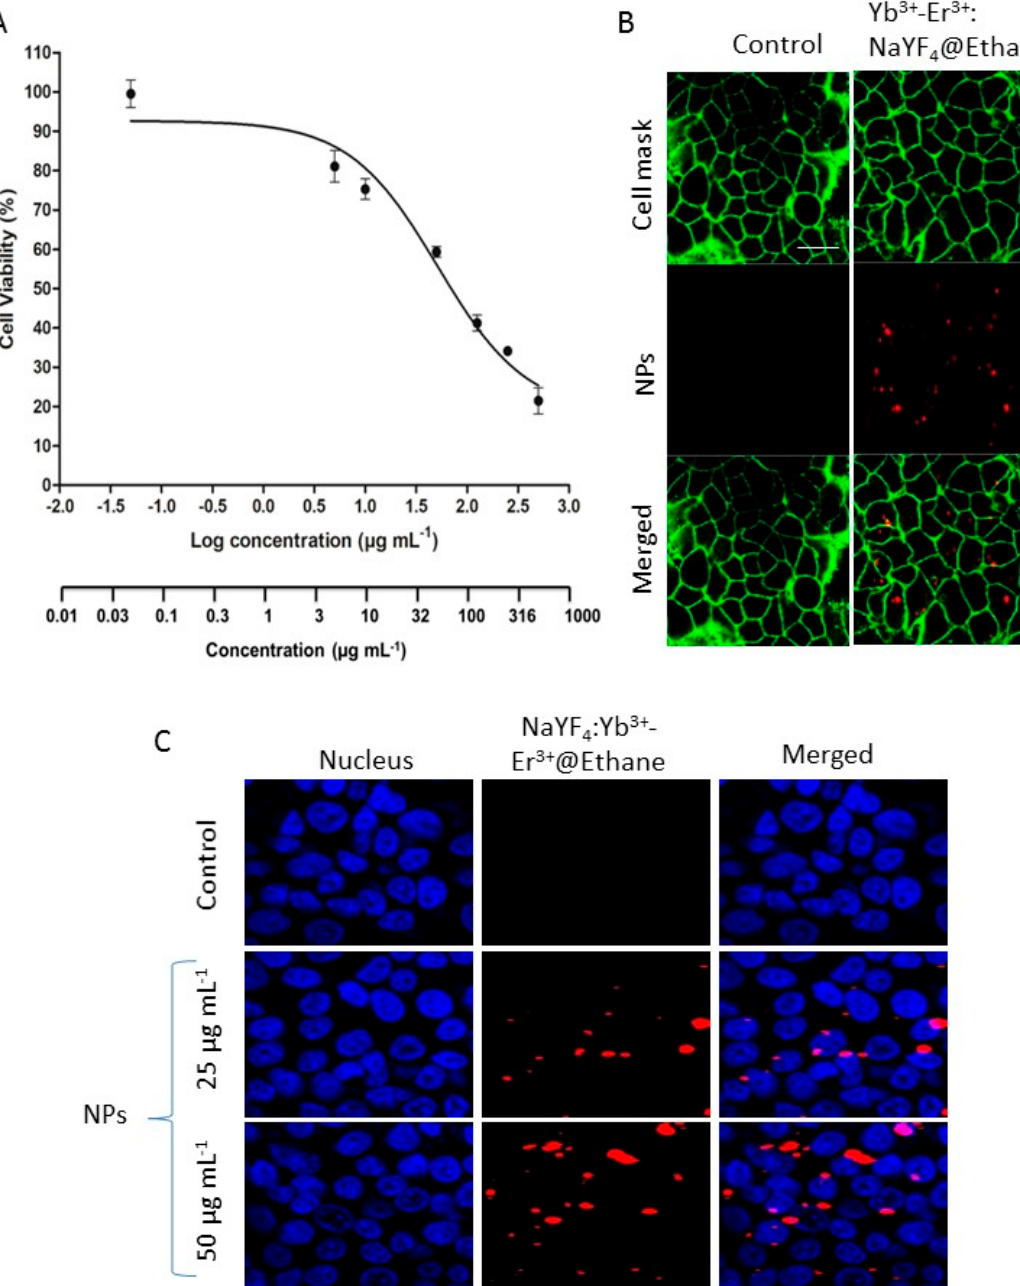
Figure 3. ( A ) Dose-response curve of MCF-7 cells treated with different concentrations of NaYF 4 : Yb 3+ -Er 3+ @Ethane for 3 days. Data are presented as mean ± SEM (n = 3). ( B ) Near-Infrared Imaging at 980 nm of MCF-7 cells incubated with cell mask (green) and NaYF 4 : Yb 3+ -Er 3+ @Ethane (red dots) at 50 µg mL − 1 . ( C ) Near-Infrared Imaging at 980 nm of MCF-7 cells incubated with Hoechst 33,342 (blue) and NaYF 4 : Yb 3+ -Er 3+ @Ethane (red dots) at 25 µg mL − 1 or 50 µg mL − 1 .